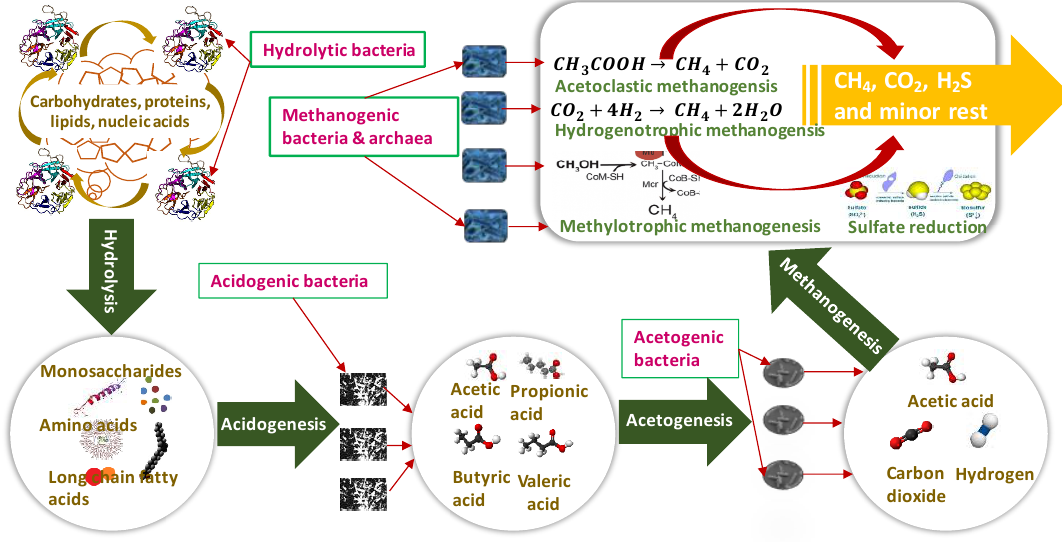
Figure 2. Simple schematic representation of anaerobic digestion steps.